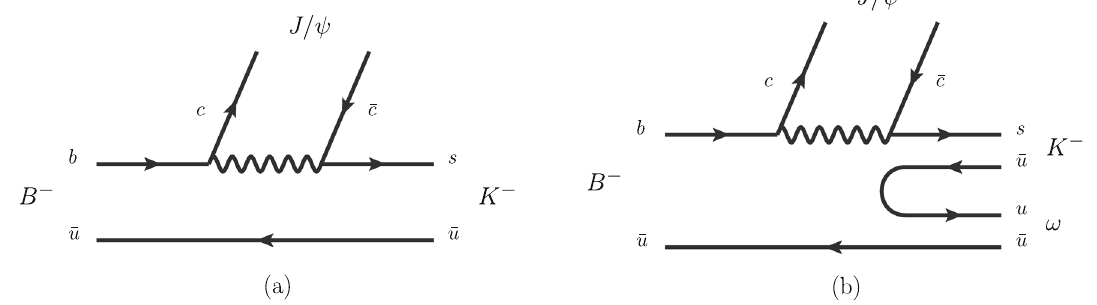
Fig. 1 Mechanism at the quark level for the reaction B − → J /ψ ω K − . a Primary quark production with internal emission. b Hadronization of the s ¯ u component into two mesons